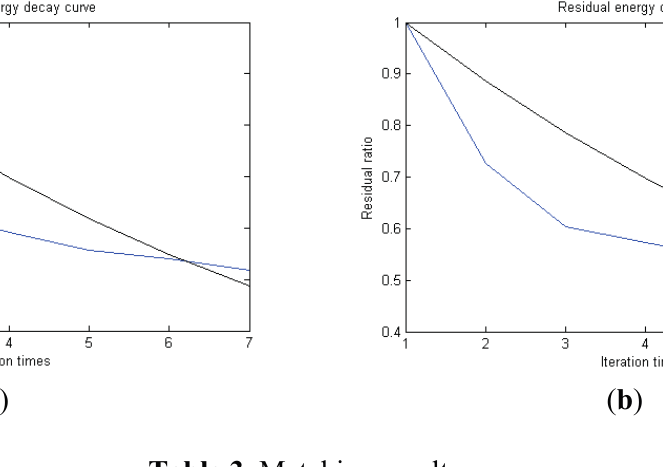
Table 3. Matching